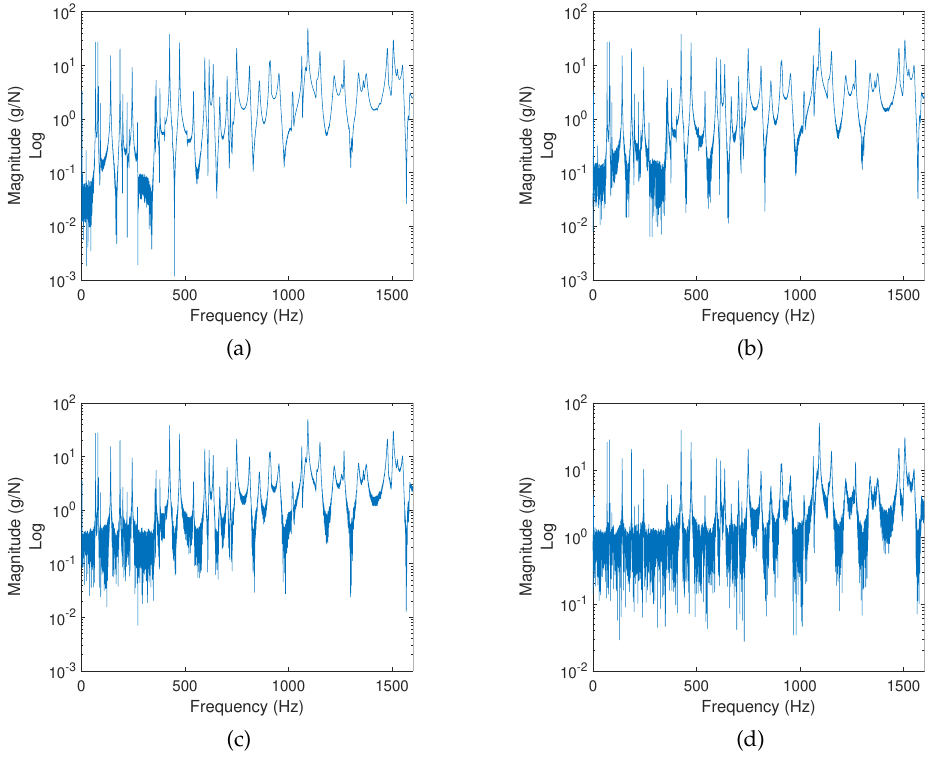
Figure 9. Noise-polluted FRFs for damage configuration M 1 and excitation E 1 . ( a ) SNR: 40 db. ( b ) SNR: 30 db. ( c ) SNR: 20 db. ( d ) SNR: 10 db.